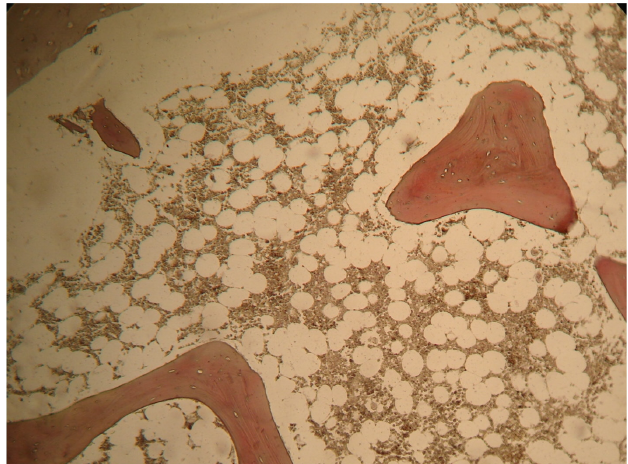
FIGURE 1A - Histological sections of normal BMB (degree 0) stained by Gomori silver solution, 100 x magnification. The fibers are stained in gray.